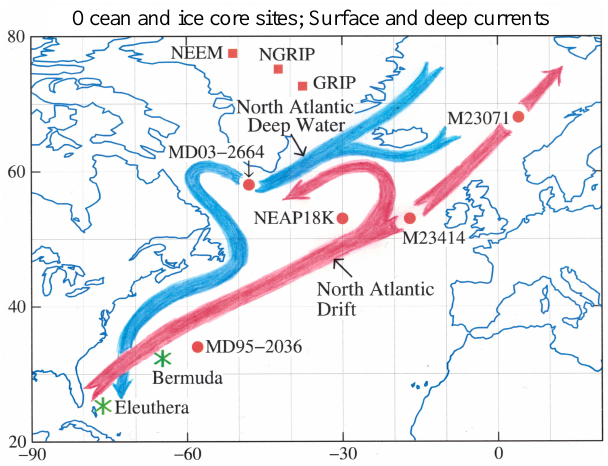
Figure 25. Ocean and ice core sites and simplified sketch of up- per ocean North Atlantic Current and North Atlantic Deep Water return flow. In interglacial periods the North Atlantic Current ex- tends further north, allowing the Greenland-Iceland-Norwegian Sea to become an important source of deepwater